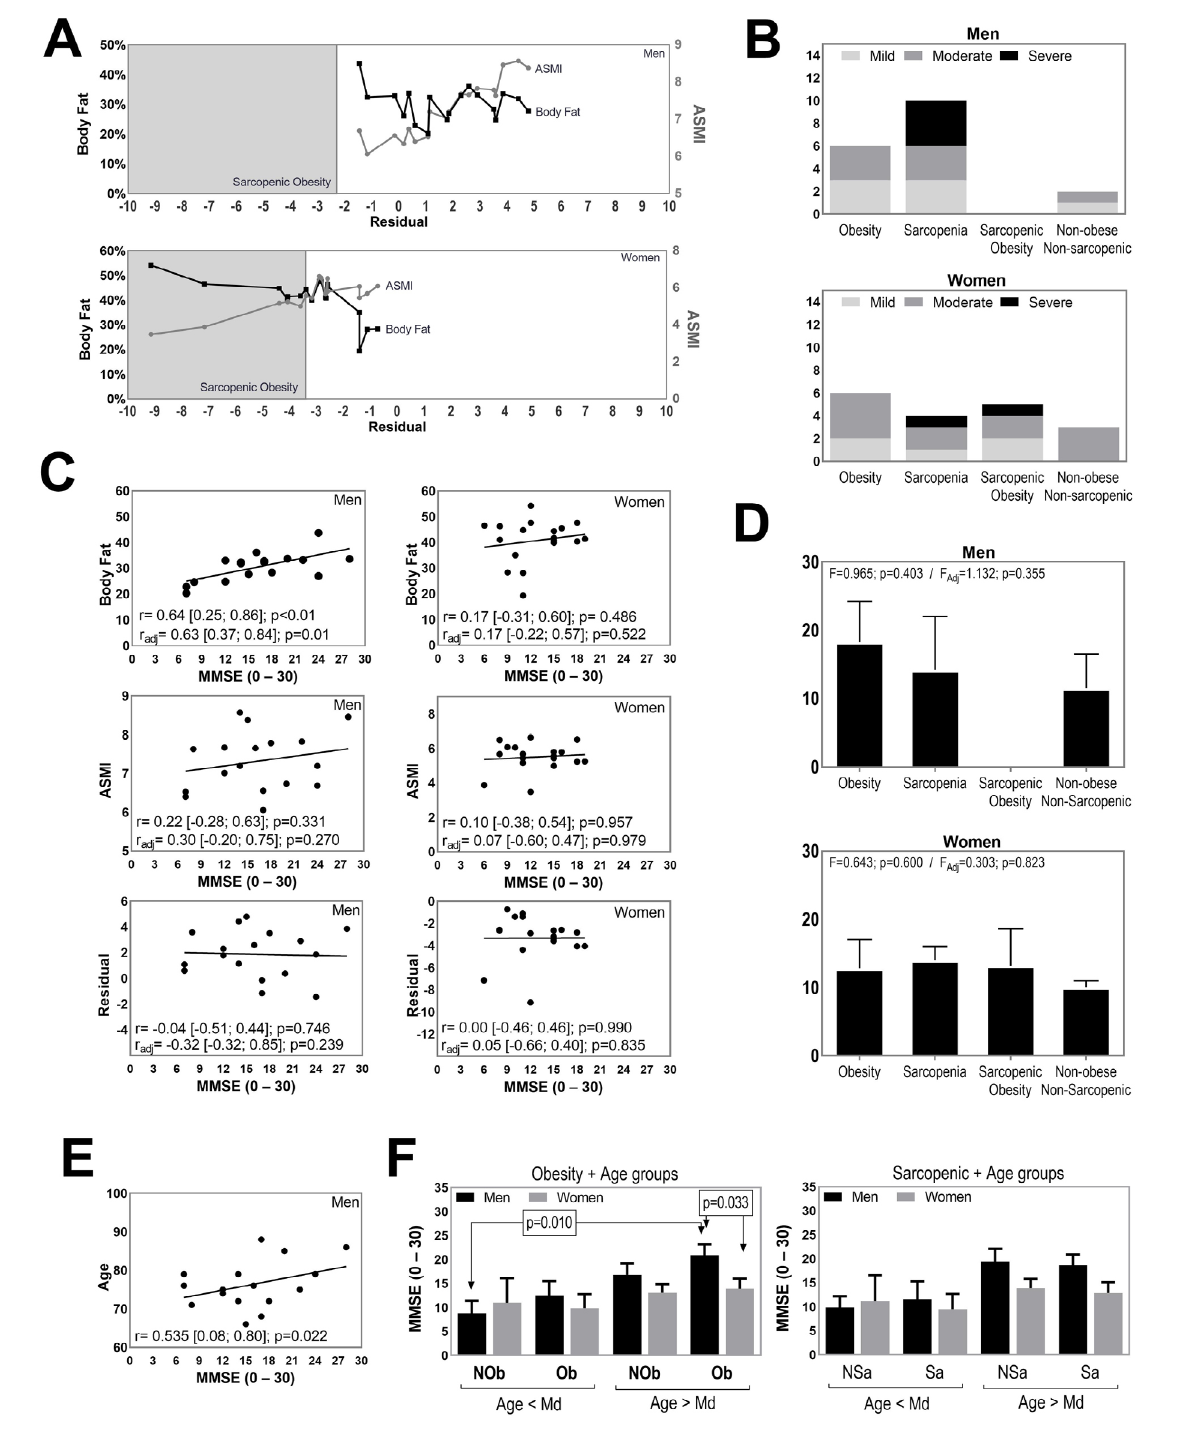
Figure 1. (A) Case-by-case appendicular skeletal muscle mass index, body fat, and residual values by sex. (B) Occurrence of obesity, sarcopenia, and sarcopenic obesity by Alzheimer’s disease stage. (C) Relationship between appendicular skeletal muscle mass index, body fat, and residual value with Mini-Mental State Examination, Pearson correlation (r), and partial correlation adjusted by age and education (r differences for Mini-Mental State Examination by clinical condition, unadjusted and adjusted by age and education (F age and Mini-Mental State Examination. (F) Mini-Mental State Examination comparison by subgroups combining age and obesity or